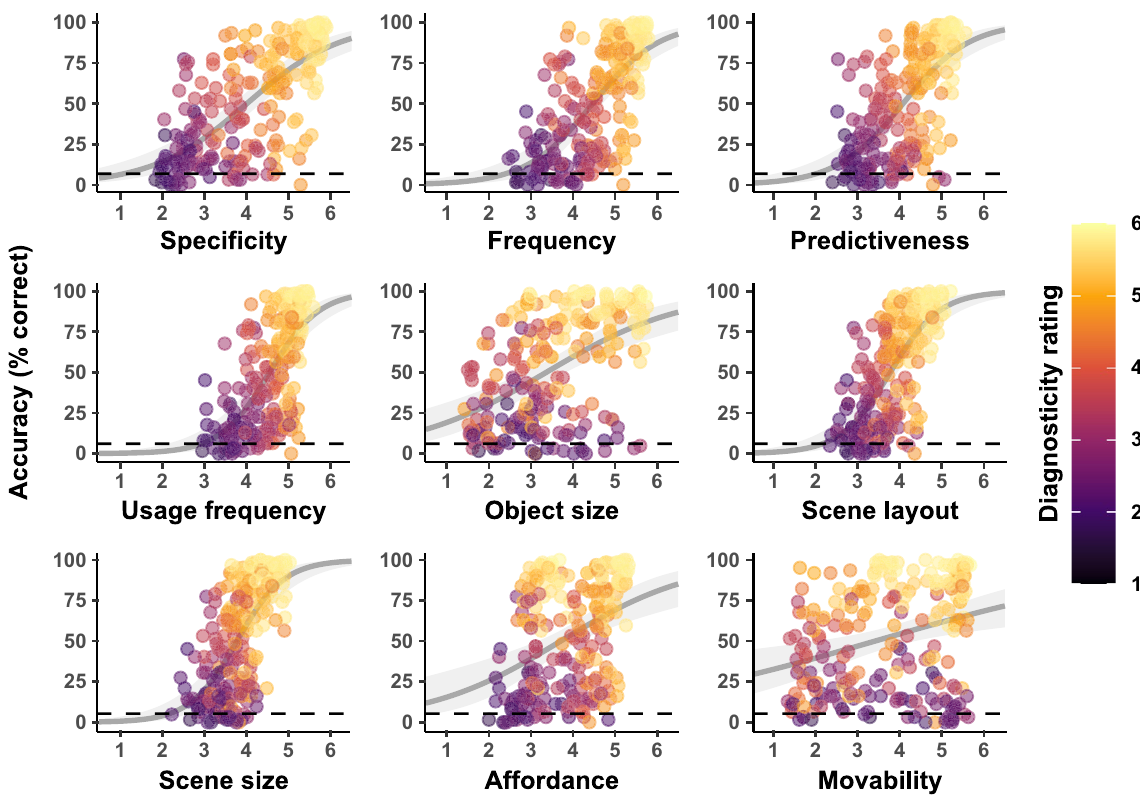
Figure 3. Observed basic-level scene categorization accuracy in Experiment 2 as a function of different ratings of object properties. Points represent the respective rating and accuracy averaged across participants for each individual image. Smoothed lines are fixed-effect binomial approximations for illustrative purposes only. The dashed lines indicate the expected chance level in the basic-level scene categorization task